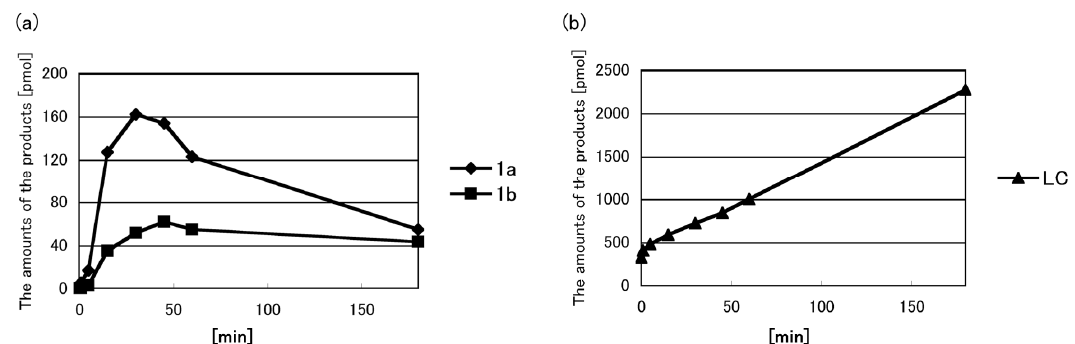
Figure 6. Time course analysis of the reaction between FMF and CKLVFF. FMF and CKLVFF in DMSO were reacted at 65 °C for 0–3 h, and then the solution was analyzed by HPLC using a Nacalai Tesque 5C18-ARII column (5 μ m, 150 × 4.6 mm) eluted with a solvent mixture of 10 mM TEAA (pH 7), 25%–35% CH CN/20 min, at a flow rate of 3